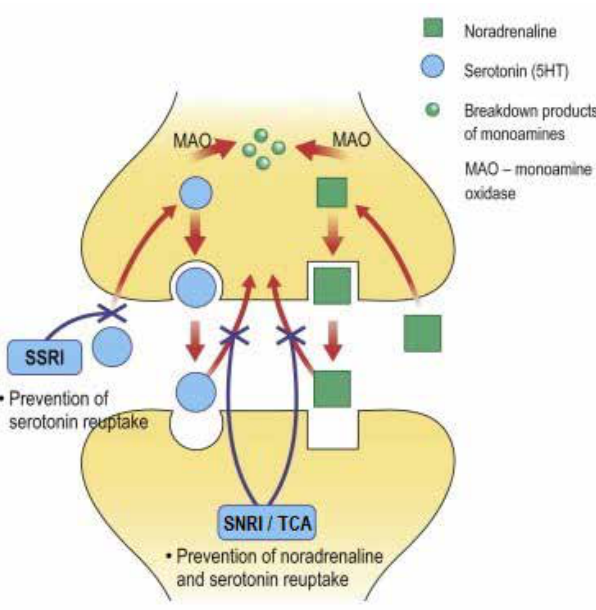
Figure 2: Mechanism of action of the SNRIs, TCAs, and SSRIs (Adapted from Stevens 33 ) SNRI - Serotonin and noradrenaline reuptake inhibitor TCA - Tricyclic antidepressant SSRI - Selective serotonin reuptake